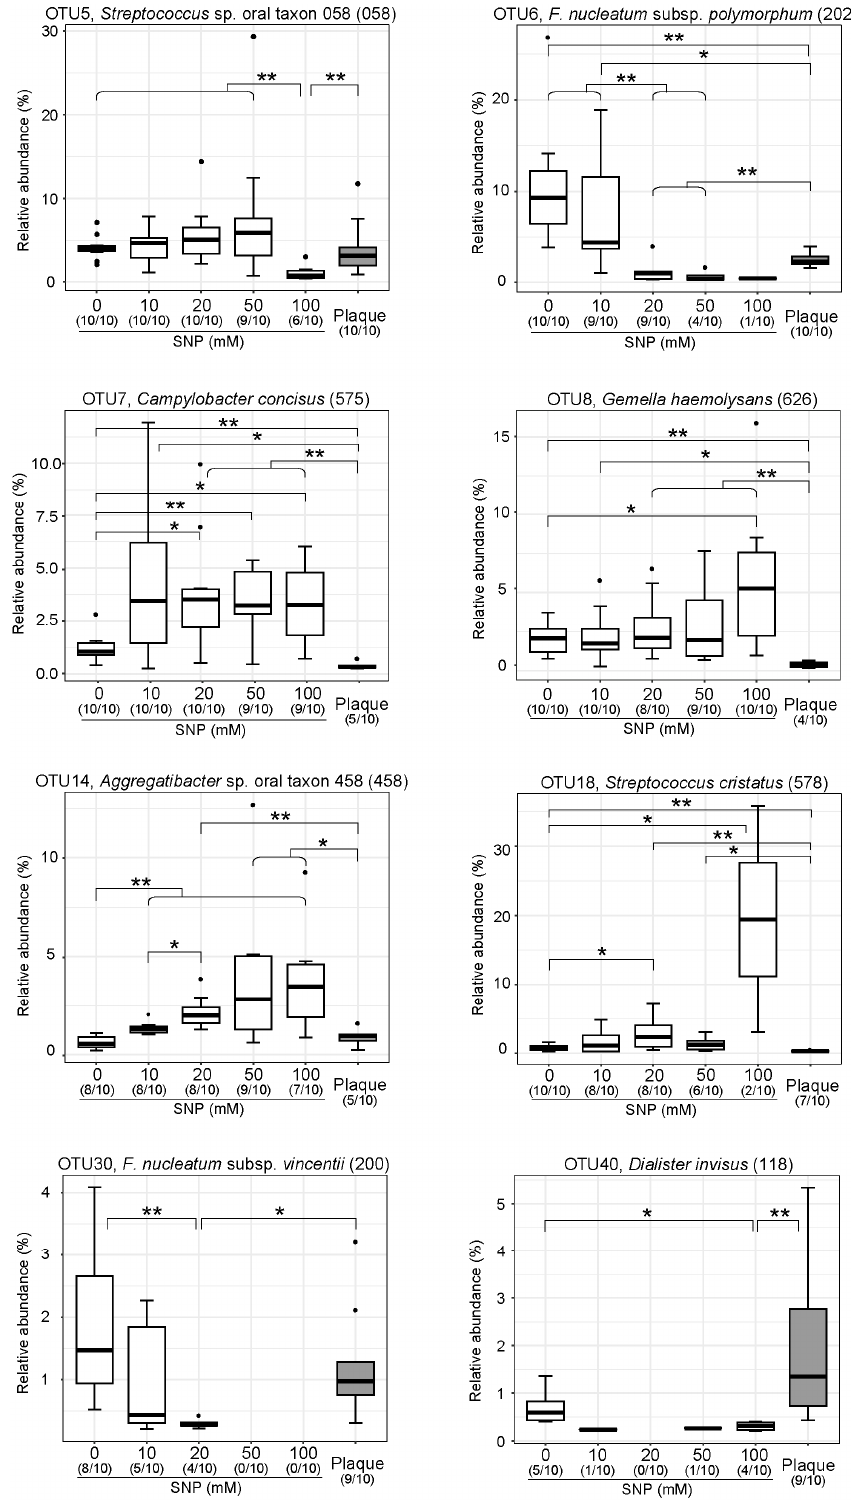
Figure 5. Relative abundance of the eight OTUs altered by SNP treatment. Differential abundance analysis was performed using the Wilcoxon rank-sum test at the OTU level (* p < 0.05, ** p < 0.01). Oral taxon IDs in HOMD are given in parentheses following bacterial names.